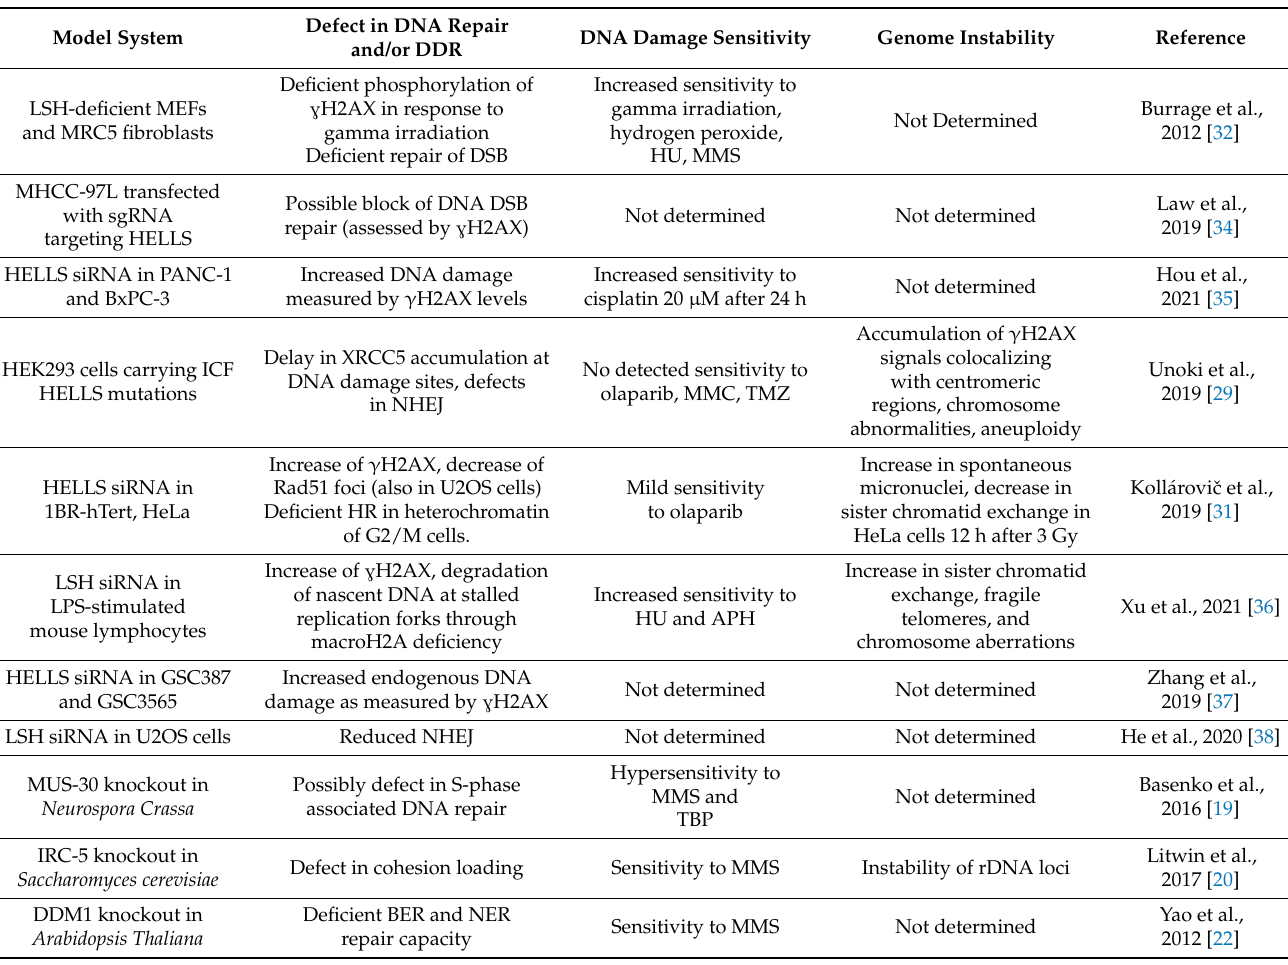
Table 1. Contribution of HELLS to various aspects of DNA repair and genome